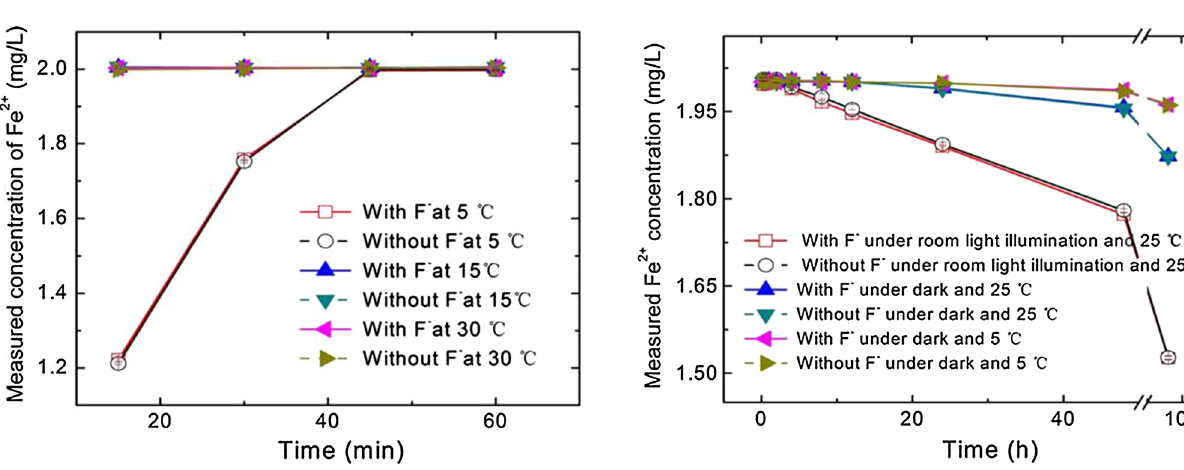
Fig. 3 Effect of temperature on the determination of Fe 2+ in the pres- ence of Fe 3+ . Experimental conditions: 2 mg/L Fe 2+ , 8 mg/L Fe 3+ and with or without the addition of 36.1 mg/L F − under room light illumination